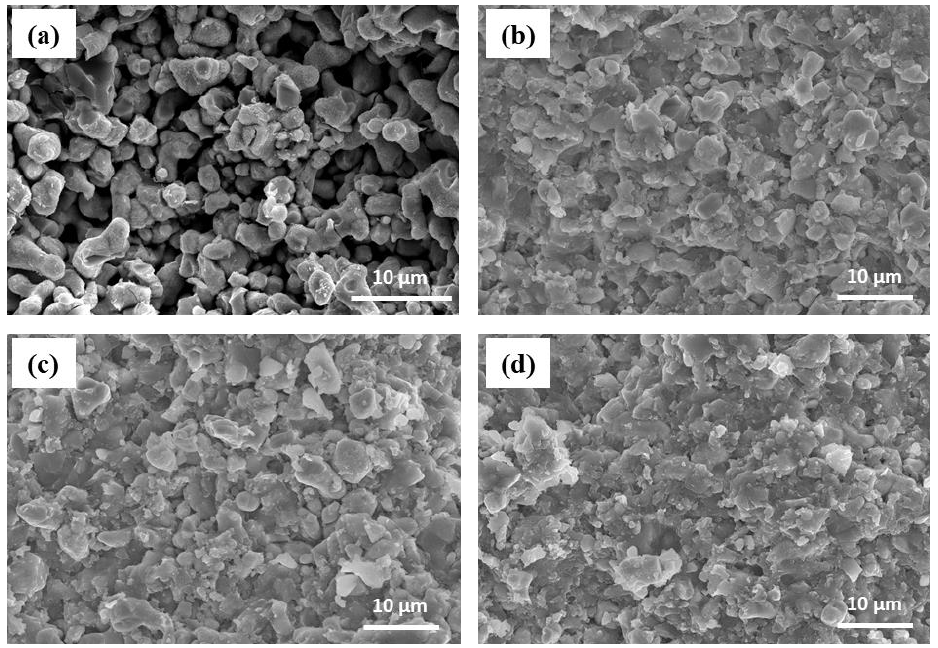
Figure 3. Cross-sectional SEM images of solid electrolytes of ( a ) LLZO ( b ) and at LLZO:LPSC = 8:2, ( c ) LLZO:LPSC = 6:4, and ( d ) LLZO:LPSC = 4:6.